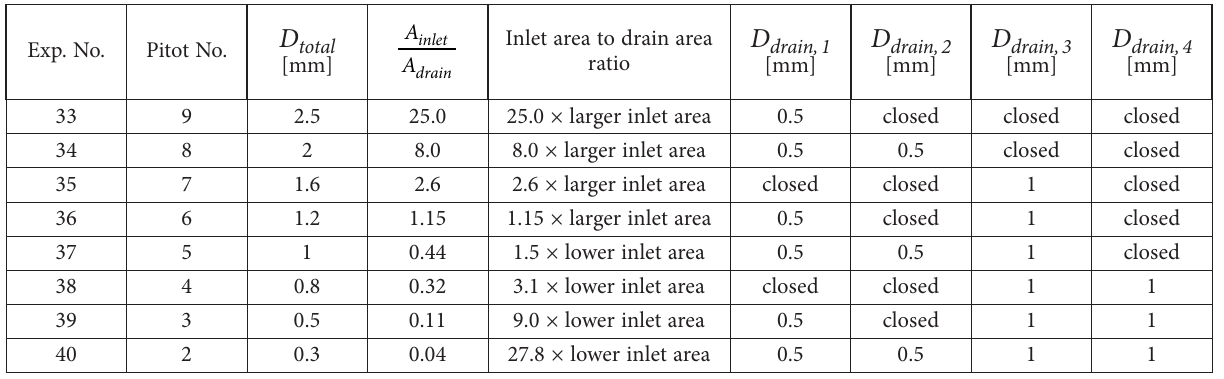
Table 5. Experiments with maximum range of A total to A drein ratio